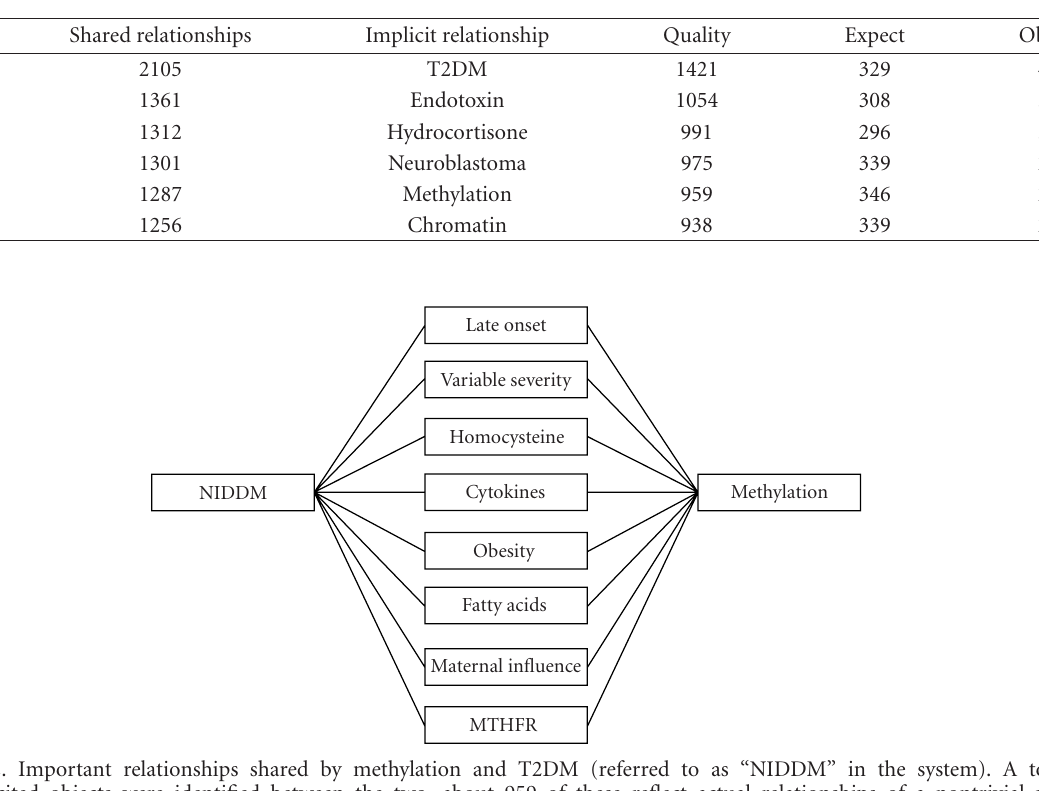
Table 2. Objects linked to T2DM solely by virtue of relationships they share within Medline. At the time of analysis, none of these objects were documented in Medline to have a relationship with T2DM (shown at top as a positive control for the query). The nature of each of these implicit relationships varies and must be determined by examination of the intermediate connections. The expected value represents how many shared relationships would be expected given a randomly connected network of relationships with the same properties of the literature-derived one. The quality score represents a statistical weighting of co-mention frequency to reflect confidence that the relationship is not of a trivial nature. The observed to expected ratio (Obs/exp) provides a ranking of how statistically exceptional any given set of shared relationships is.